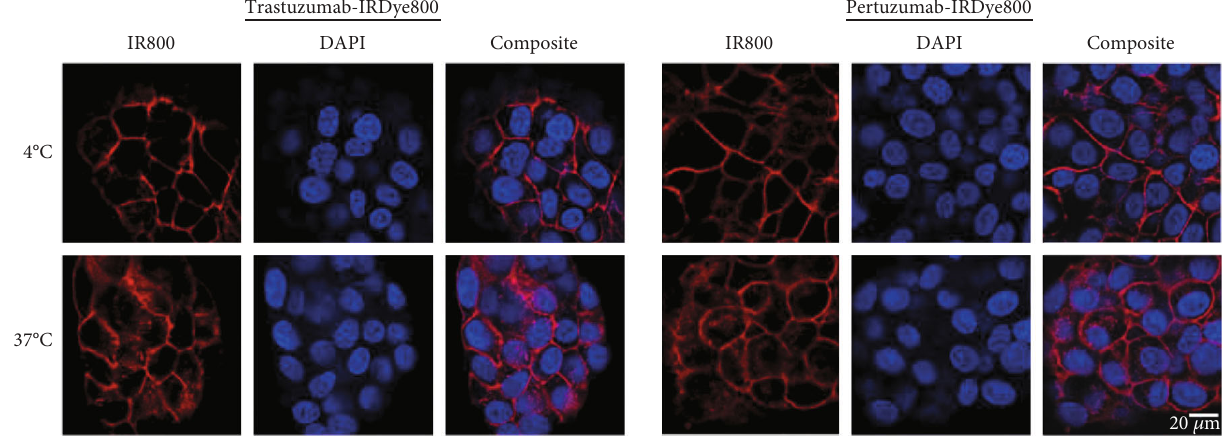
Figure 3: Confocal microscopy examination of cell surface binding and internalization of mAb-IRDye800 on BT474 cells at 4 ˚ C (top) and 37 ˚ C